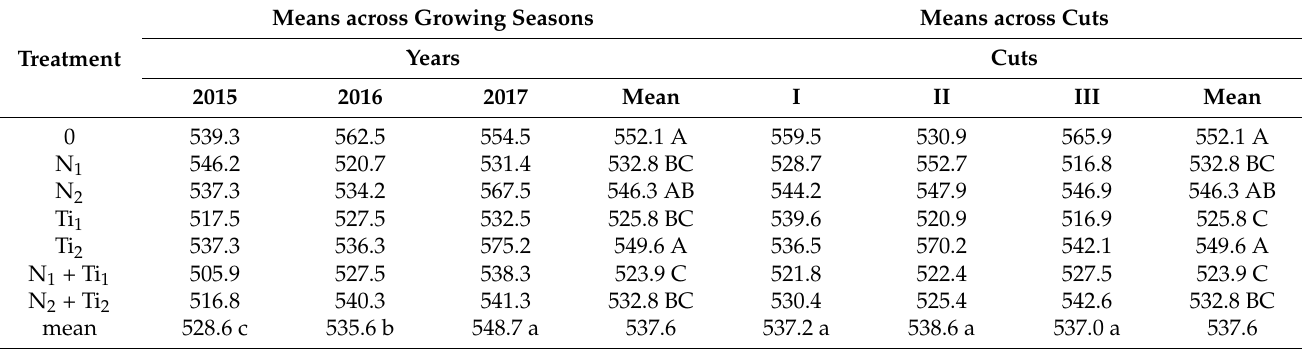
Table 4. Neutral detergent fibre (NDF) content in Festulolium braunii (g kg − 1 DM). Means across Growing Treatment